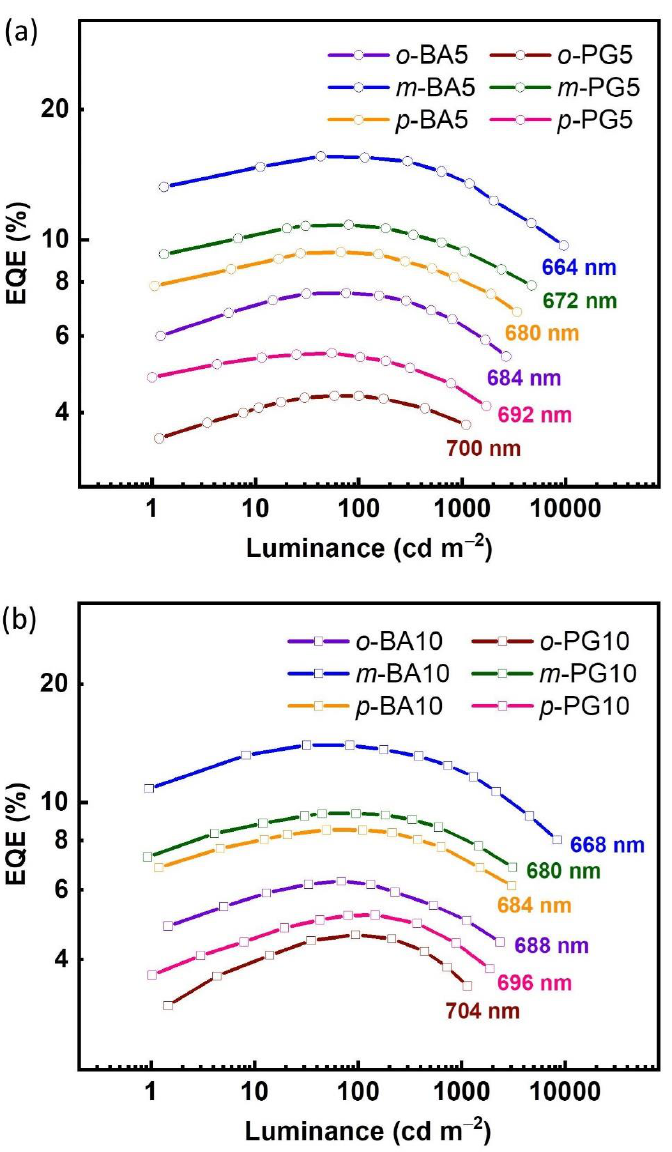
Figure 6. External quantum efficiency–luminance (EQE– L ) curves of the devices with doping concentrations of 5 wt% ( a ) and 10 wt% ( b ). Table 3. Summary of the EL performance for all devices.